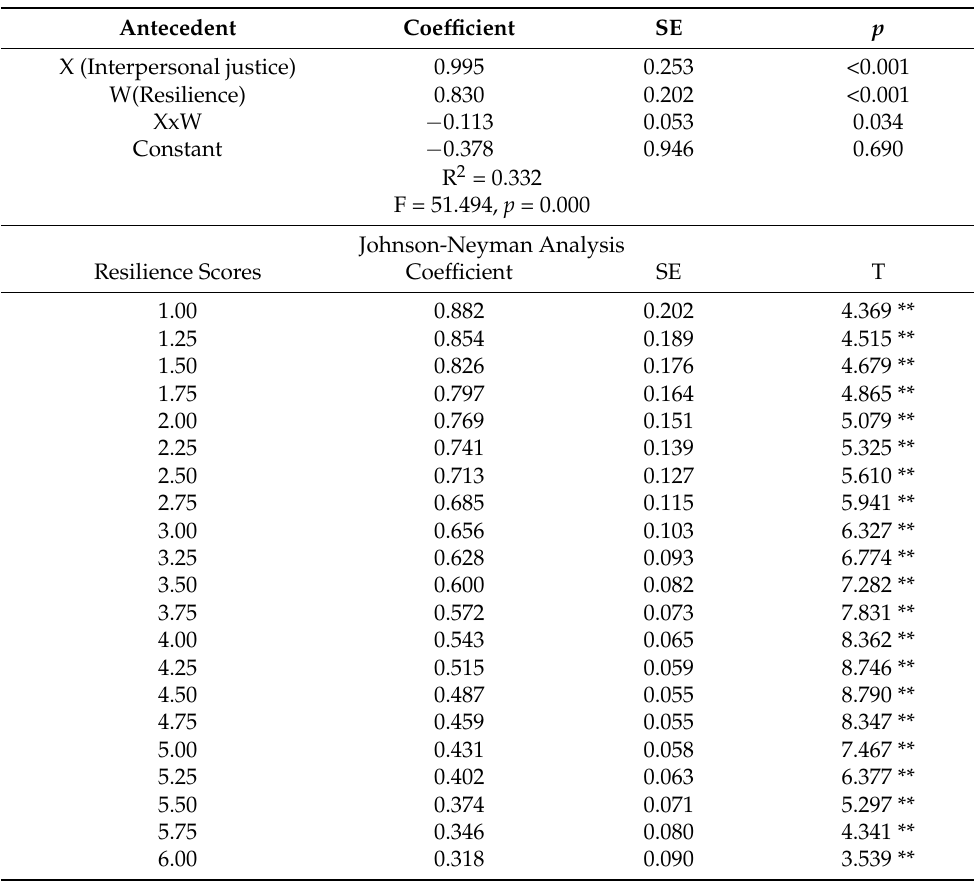
Table 4. Results of the regression analysis examining the modulating effect of resilience on the influence of interpersonal justice on job satisfaction. Antecedent Coefficient SE p X (Interpersonal justice) 0.995 0.253 <0.001 W(Resilience) 0.830 0.202 <0.001 XxW − 0.113